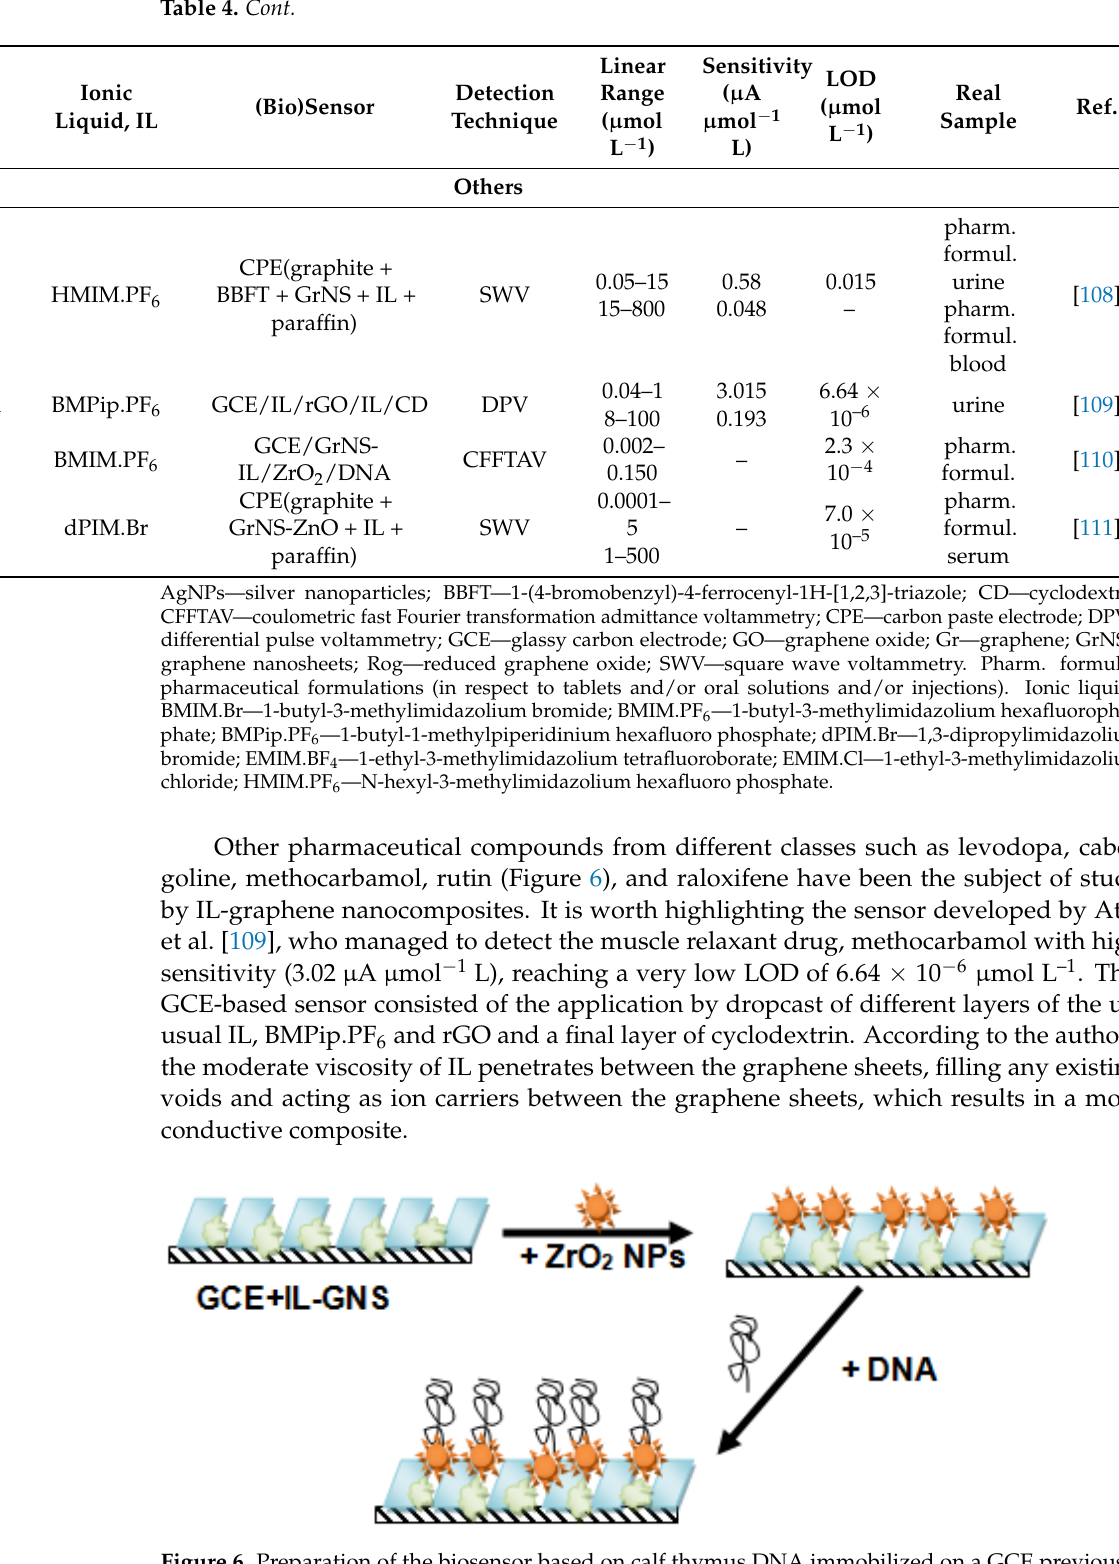
Figure 6. Preparation of the biosensor based on calf thymus DNA immobilized on a GCE previously modified with graphene nanosheets (GNS), 1-butyl-3-methylimidazolium hexafluorophosphate ionic liquid (BMIMPF 6 ), and ZrO 2 nanoparticles for the detection of rutin (reproduced from Norouzi et al. [110], with permission from International Journal of Electrochemical Science).